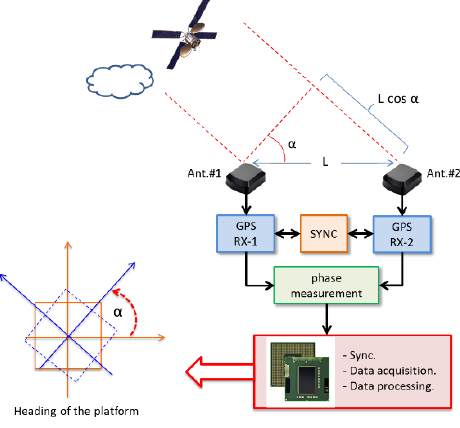
Figure 6: Multi-antenna schematic